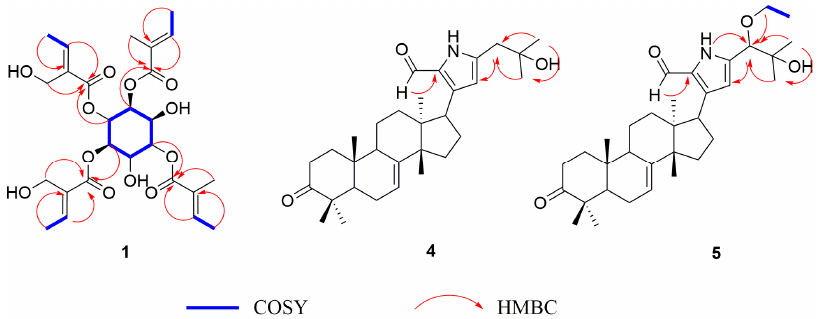
Figure 2. 1 H- 1 H COSY and HMBC correlations of 1 , 4 and 5 .